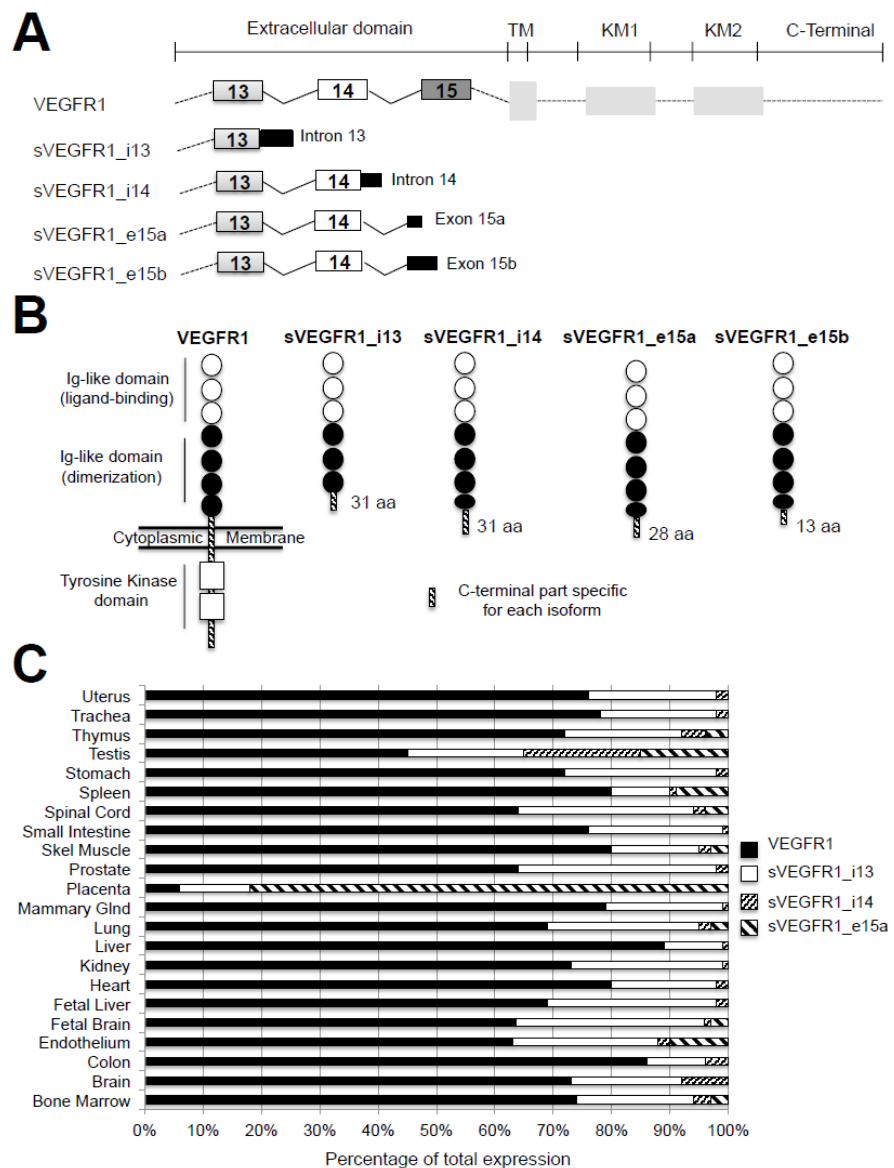
Figure 3. The different VEGFR1 splice variants, proteins and expression in tissues. ( A ) Schematic representation of full-length VEGFR1, sVEGFR1_i13, sVEGFR1_i14, sVEGFR1-e15a, and sVEGFR1-